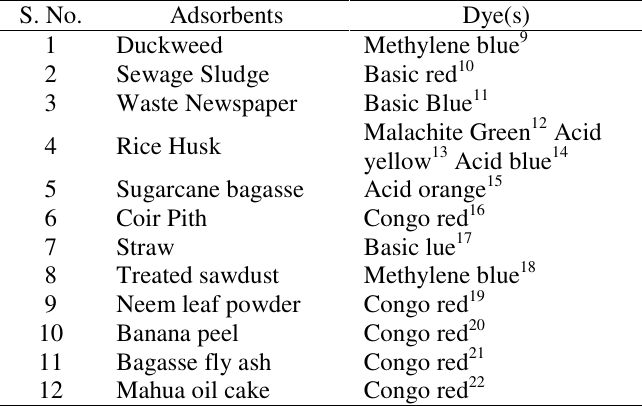
Table 1. Comparison for adsorption of some dyes on various